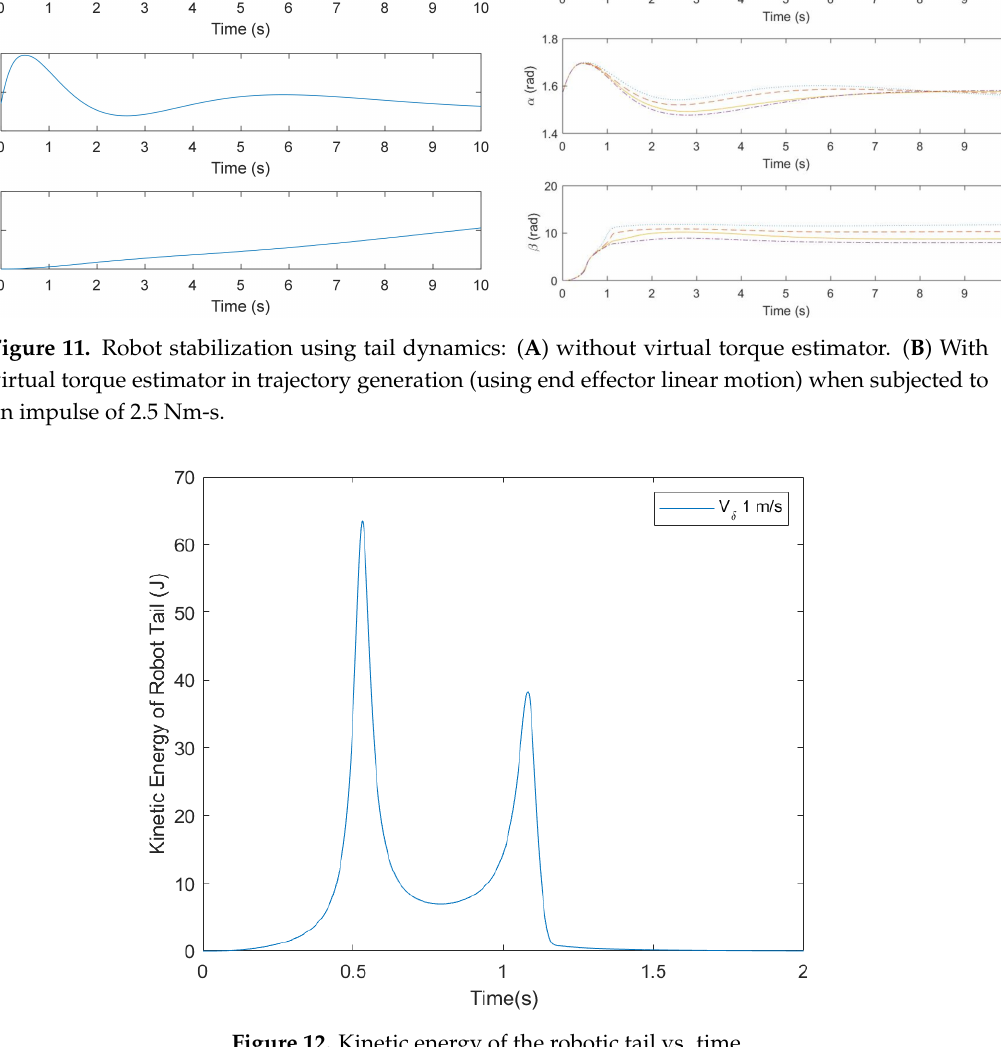
Figure 12. Kinetic energy of the robotic tail vs.